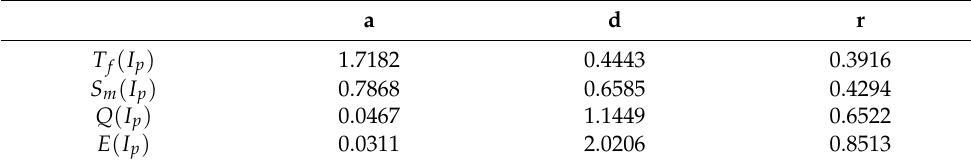
Table 9. Correlation coefficients for peak current and other lightning